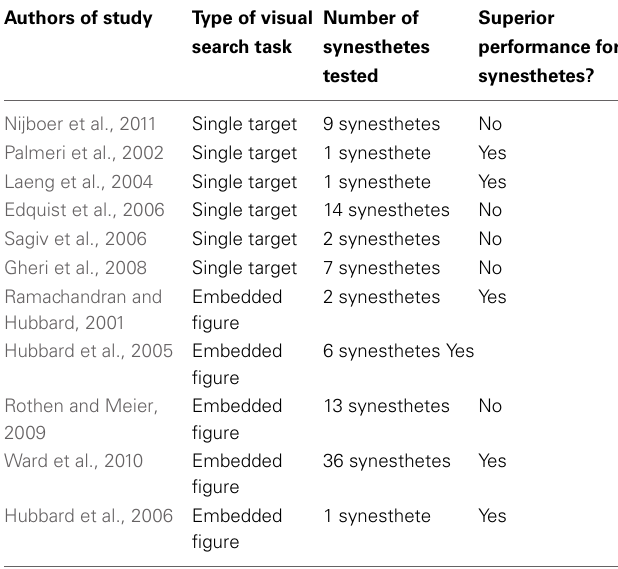
Table 1 | A summary of studies testing the performance of synesthetes using visual search